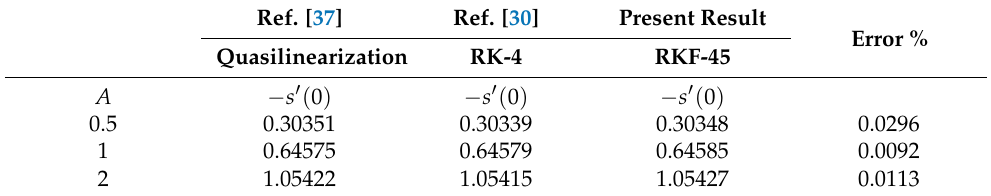
Table 6. Comparison of − s (cid:48) ( 0 ) for several values of A in the absence of φ . Ref. [37]